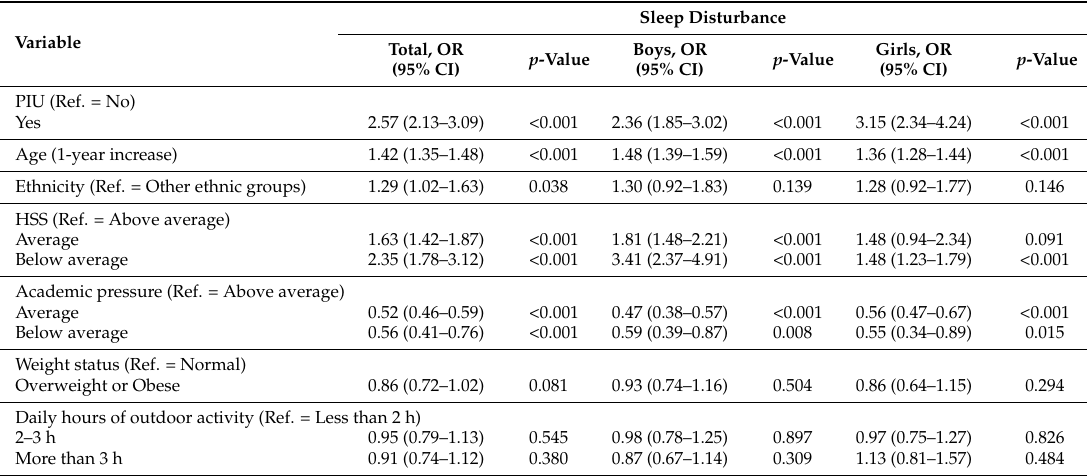
Table 2. Unadjusted odds ratios and 95% confidence interval of sleep disturbance among adolescents: two-level logistic regression analyses.